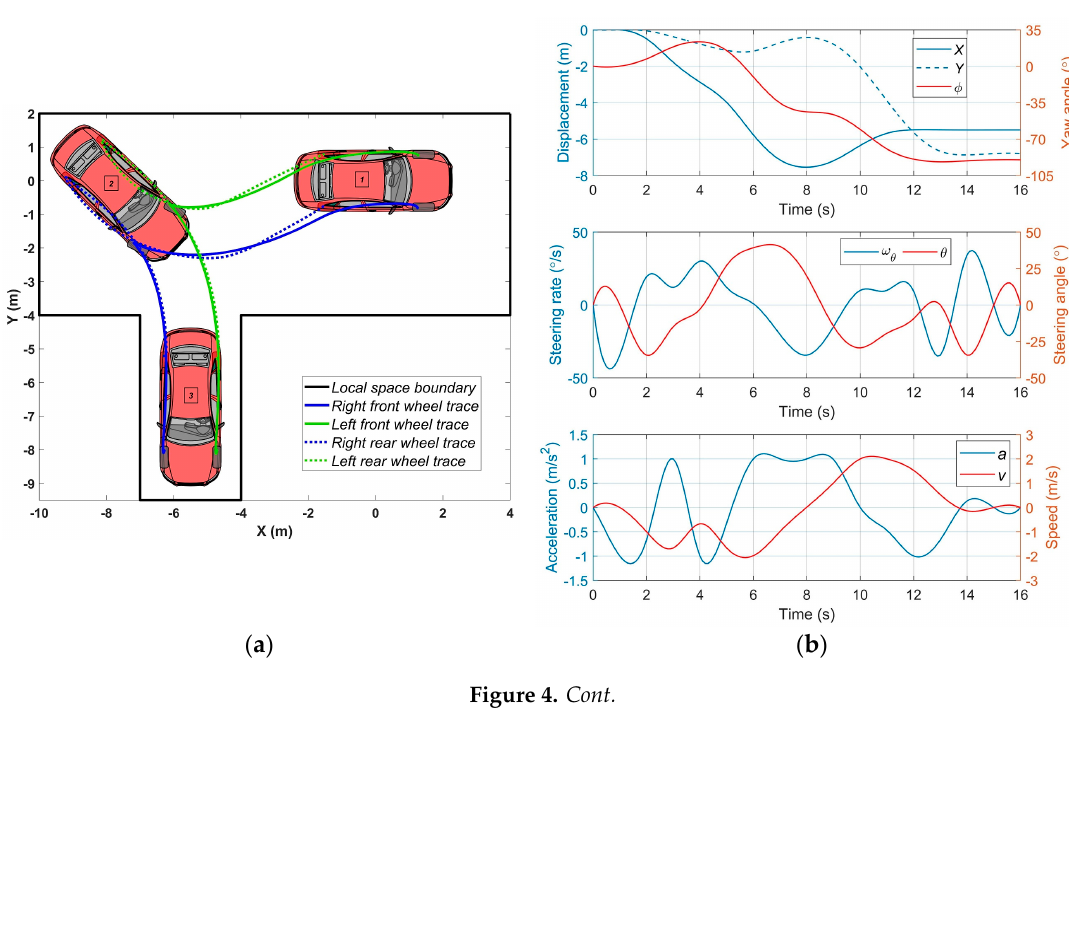
( d ) Figure 4. Simulation results for perpendicular forward parking and circular motion of a passenger car: ( a ) Position and trajectory (perpendicular forward); ( b ) Basic parameters (perpendicular forward); ( c ) Car positions and planned trajectories (circular); ( d ) Car's output and control parameters (circular). 4.2. Simulation of Long Single Truck with Steered Rear Axle The parameter for this model is the full wheelbase L = L 10 + l 10 , consisting of longitudinal wheelbase L 10 = 6.65 m between steering and driving axles and spread axles' wheelbase l 10 = 1.4 m. Equations (24)–(26) are used for model prediction. Consider first the parking maneuver (Figure 5a, 5b). In the case of perpendicular reverse parking, the following objectives are set for optimizing the maneuver: reducing the use of space, ensuring the smoothness of the control functions, and redistributing the control between the vehicle's steered axles to provide the minimal total steering control. In particular, the vehicle maneuver is better to be oriented in a way that there are the